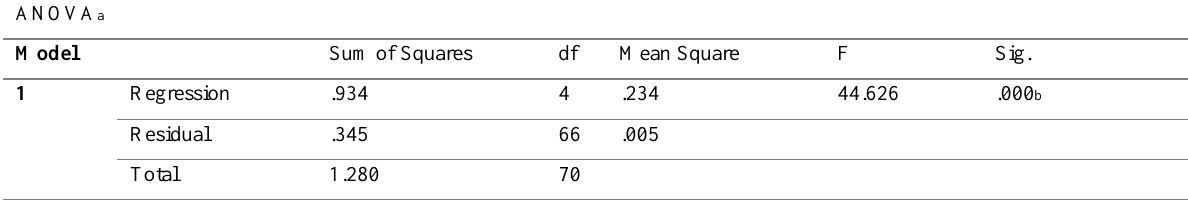
Table 2: ANOVA Relationship between Culture and Strategy Implementation